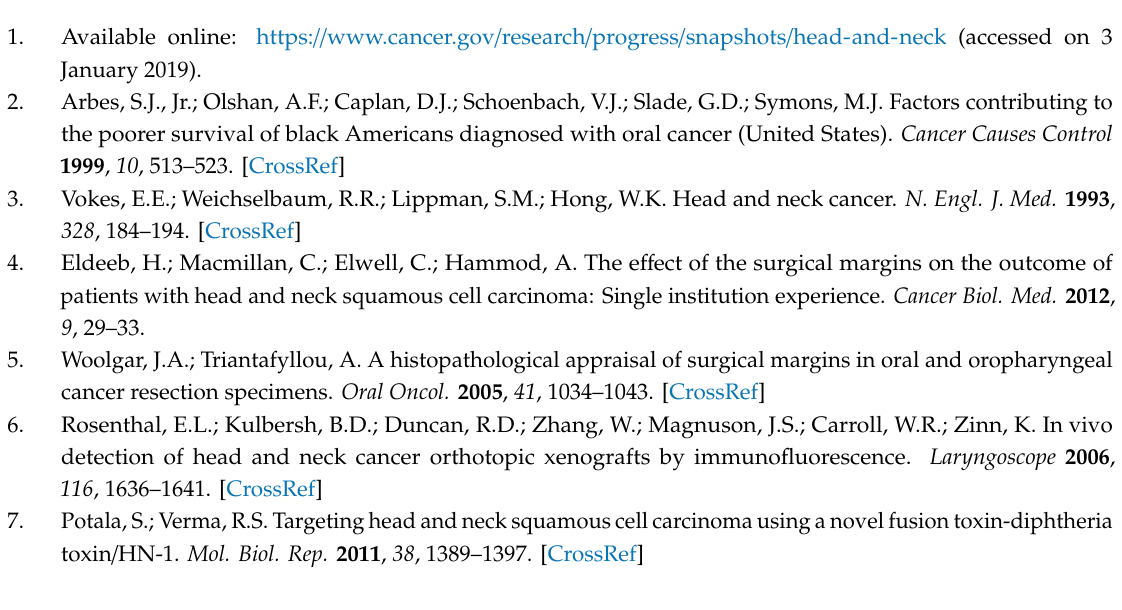
Figure S1: NIRF signal vs. concentration and FBS for peptides. Figure S2: Cal 27 uptake of peptide in lysed vs. unlysed cells. Figure S3: Cell uptake of peptides at 1 and 2 h incubations. Figure S4: Fluorescent microscopy showing uptake of 4Iphf-HN17-IR800 in Cal 27 cells. Figure S5: Blood clearance and urine accumulation of peptides in mice. Table S1: HPLC Purity, mass spectral identity, HPLC lipophilicity, and cell uptake of peptides. Figure S6: Plot of Cal 27 cell uptake vs. lipophilicity of peptides. Figure S7: Fluobeam optical images of normal organs after peptide administration. Table S2: Data set used to generate fluorescent intensities in uptake experiments. Table S3: Numerical data plotted in Figure 2 with uncertainty and p